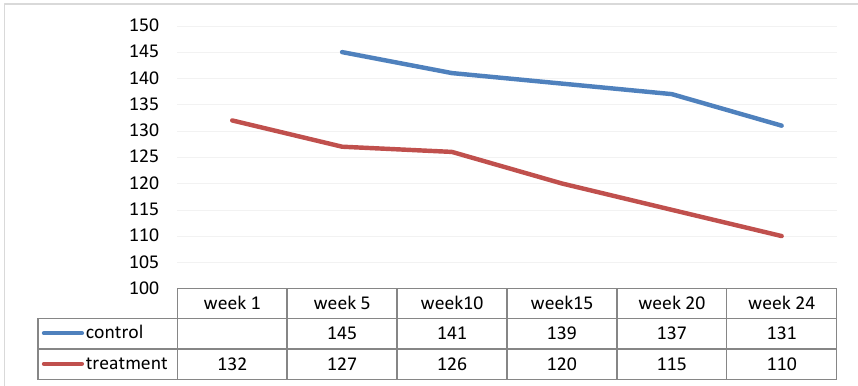
Figure 1. Comparison of the systolic blood pressure in two groups at a different